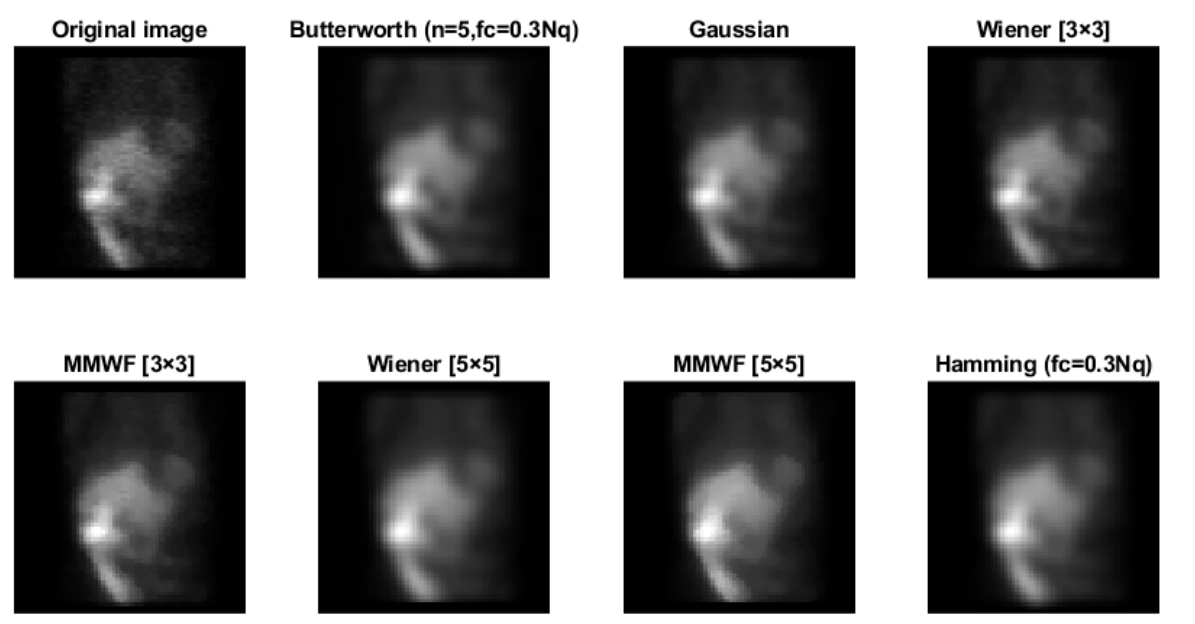
Figure 7. Images obtained by filtering the image of Figure 3 with Butterworth ( n = 5, fc = 0.3 Nq), Gaussian, Wiener (3 × 3), MMWF (3 × 3), Wiener (5 × 5), MMWF (5 × 5), and Hamming (fc = 0.3 Nq) filters (x × x represents the kernel size).